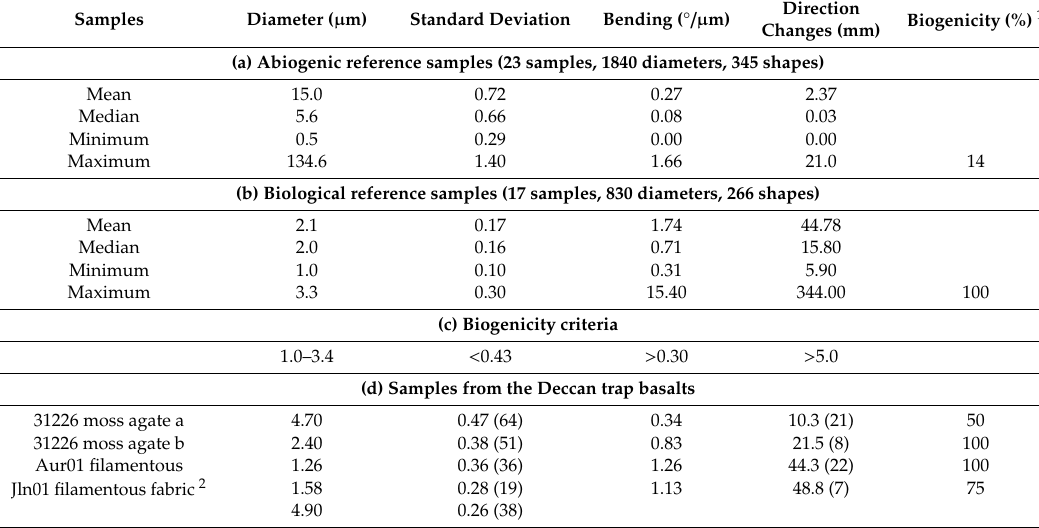
Table 3. Filament morphometry data of MDP filamentous samples compared with biogenic and abiogenic samples; the numbers in brackets in (d) show the number of